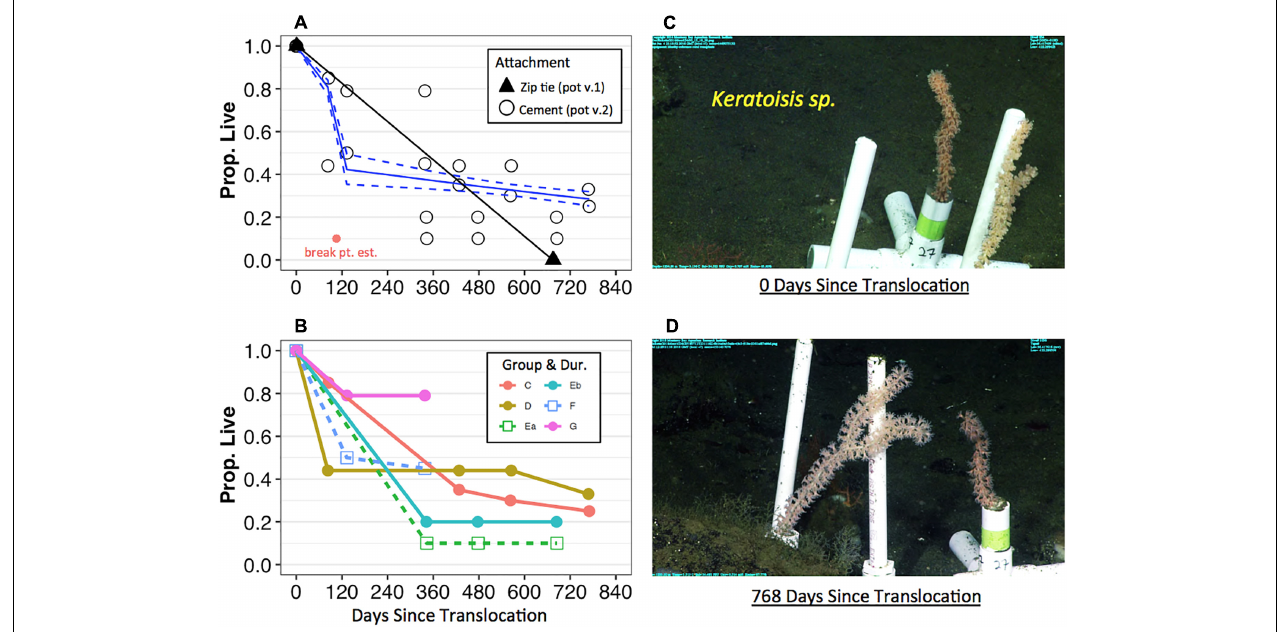
FIGURE 2 | Survivorship of translocated deep-sea corals by attachment, deployment group, and transport treatment over time at Sur Ridge, California (coral pot v.2). (A) Solid black triangles represent the proportion of live coral over time relative to the total number of initial fragments using the zip tie attachment method (coral pot v.1). The triangle symbols that represent data for Keratoisis sp., I. tentaculum , and P. arborea overlap. Open black circles represent the proportion of live corals over time using the cement attachment method (coral pot v.2). Solid red circle represents the breaking point estimate (105.5 ± 4.9 SE days) for the coral pot v.2 data. Solid blue lines indicate segmented GLM fit with upper and lower confidence limit estimates (dashed blue lines). (B) Solid colored circles represent the proportion of live corals relative to the total number of initial fragments since the day of deployment—i.e., these corals were translocated to depth on the same day of collection. Open square symbols represent the proportion of live corals that were translocated on the day after collection. The numbers of coral fragments are reported in Table 1 for each deployment group and by taxa. (C) Example of Keratoisis sp. from Group D deployment—i.e., 0 days since translocation (June 4, 2016). (D) The same Keratoisis sp. samples from group D—768 days since translocation (July 12, 2018). The photo on the revisit could not be taken from exactly same camera angle but the #27 coral pot is clear in both panels (C,D) . For panels (A,B) , 0 days = the initial time when coral pots were translocated at depth.